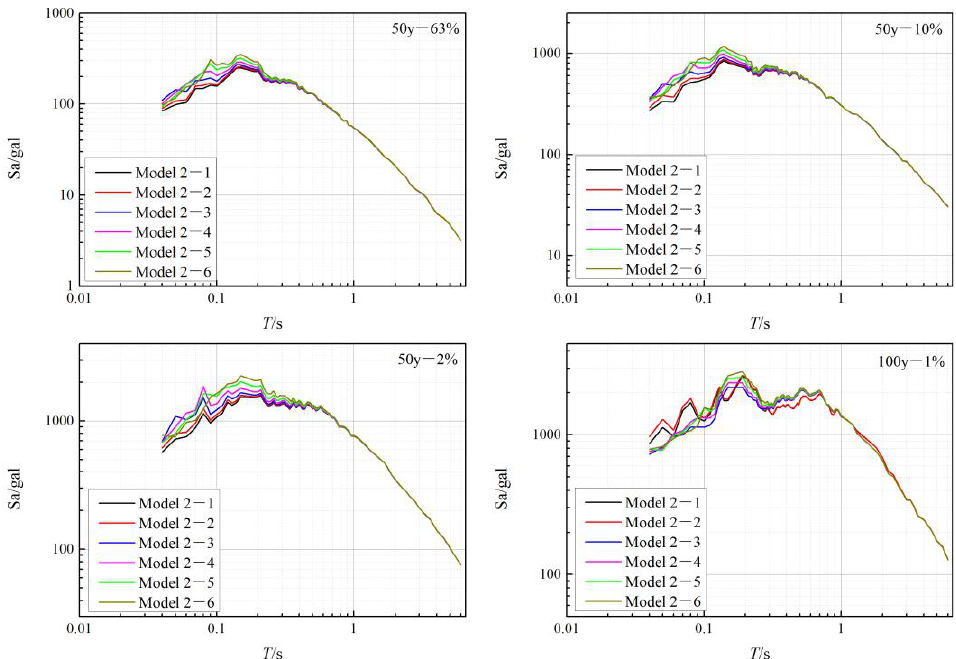
Figure 9. Spectral accelerations for the different thicknesses of silty clay layer under four seismic inputs.